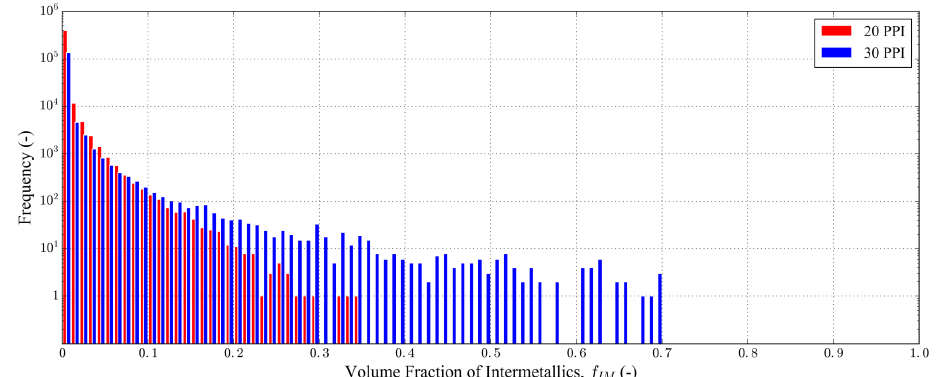
Figure 3. Distributions of intermetallic particles volume fraction in the finite element (FE) tetrahedra for the 20 PPI and 30 PPI foam